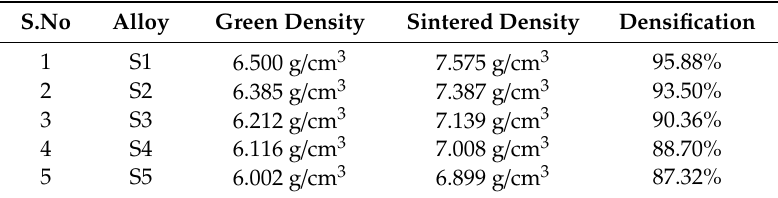
Table 3. Densities of all the